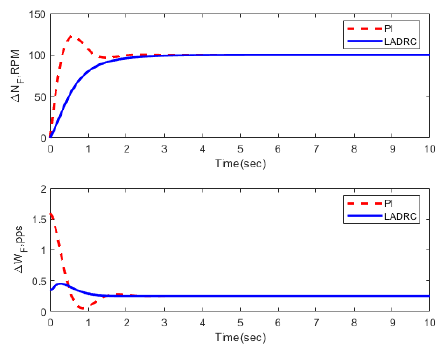
Figure 17. Step response of FC08.